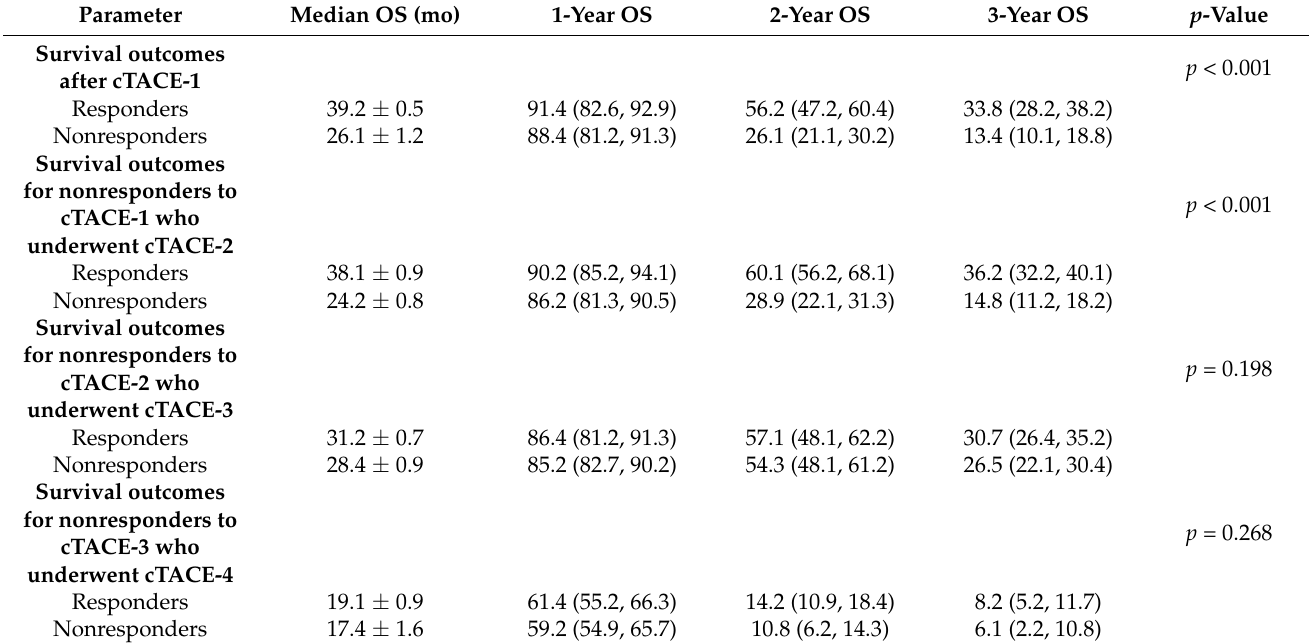
Table 3. Survival outcomes for responders and nonresponders in the training